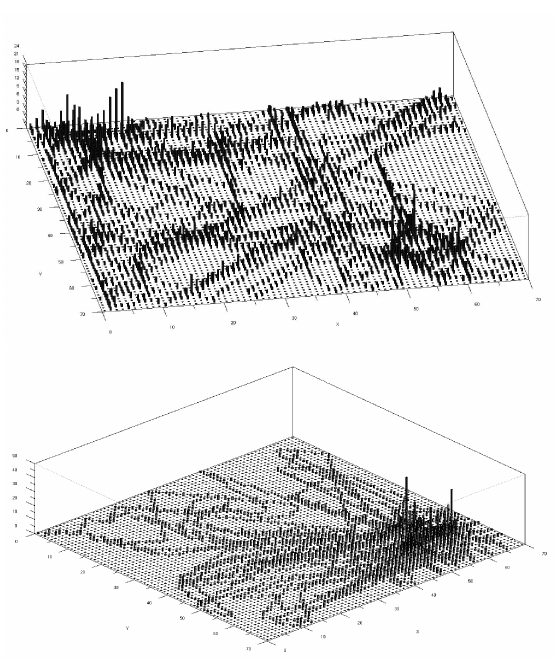
Figure 10. Two types of behaviors in the case where two “villages” exist: in the left picture, the agent “oscillates” between resources belonging to different villages, in the right picture it sticks to one of the villages. The graphics represent the density of presence of the agent after 5,000 time steps. There were no obstacles during this simulation, and only one agent’s moves are recorded in each case.